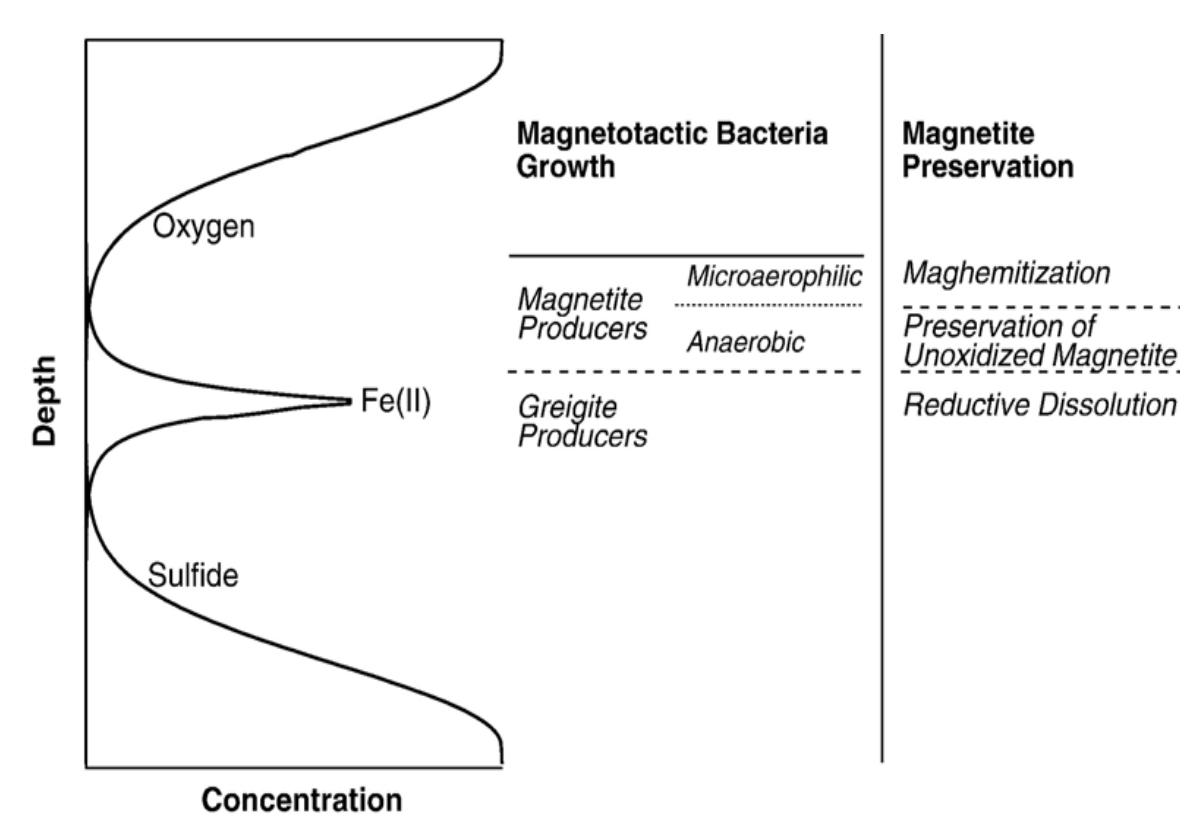
Figure 1. Scheme of chemical gradients vs. typical depth optimal for the growth of various types of magnetotactic bacteria and magnetite transformations. Magnetite (greigite) crystals provide the bacteria with a net magnetic moment, which they employ for magnetotaxis, movement directed by the local magnetic field. Many magnetotactic bacteria grow preferentially under specific, narrow redox conditions. Redox gradients can exist on scales from millimeters to meters. Reprinted from [14], Earth-Science Reviews, Vol. 86, Kopp R.E., Kirschvink J.L., “The identification and biogeochemical interpretation of fossil magnetotactic bacteria”, pp. 42–61, 2008, with permission from Elsevier.